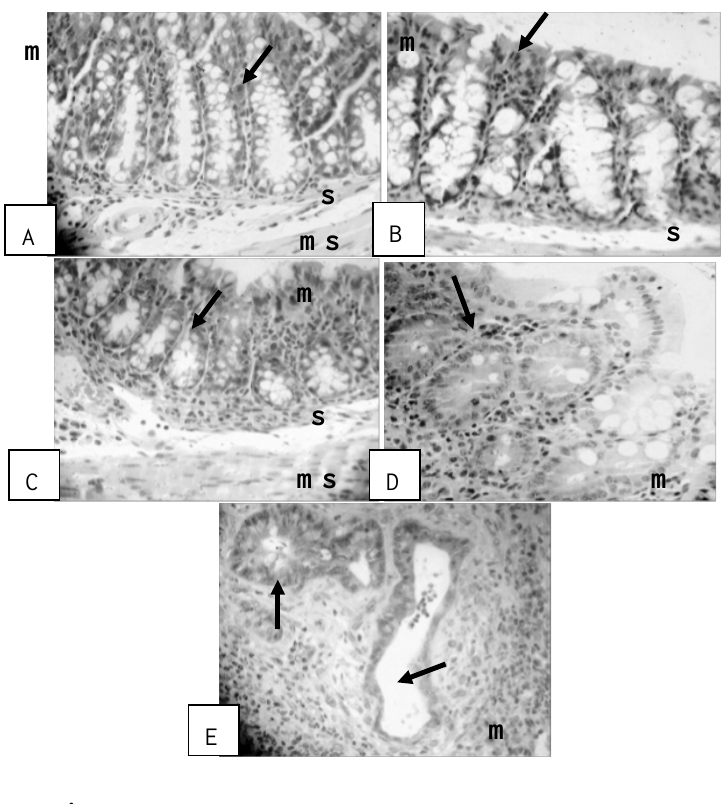
Figure 1. Histological assessment of colonic inflammation. ( A ) Score 0: no inflammation with normal crypt and goblet cells (arrow); m: mucosa; s: submucosa; ms: muscularis. H & E, 400×; ( B ) Score 1: minimal evidence of inflammatory infiltrate (arrow), H & E, 400×; ( C ) Score 2: significant evidence of inflammatory infiltrate (arrow), H & E, 400×; ( D ) Score 3: significant evidence of inflammatory infiltrate with goblet cell depletion (arrow), H & E, 400×; ( E ) Score 4: severe inflammation characterized by widespread infiltration with inflammatory cells, formation of crypt abscesses (arrows), mucosal thickening, submucosal cell infiltration, a decrease in goblet cells and destruction of architecture, H & E,